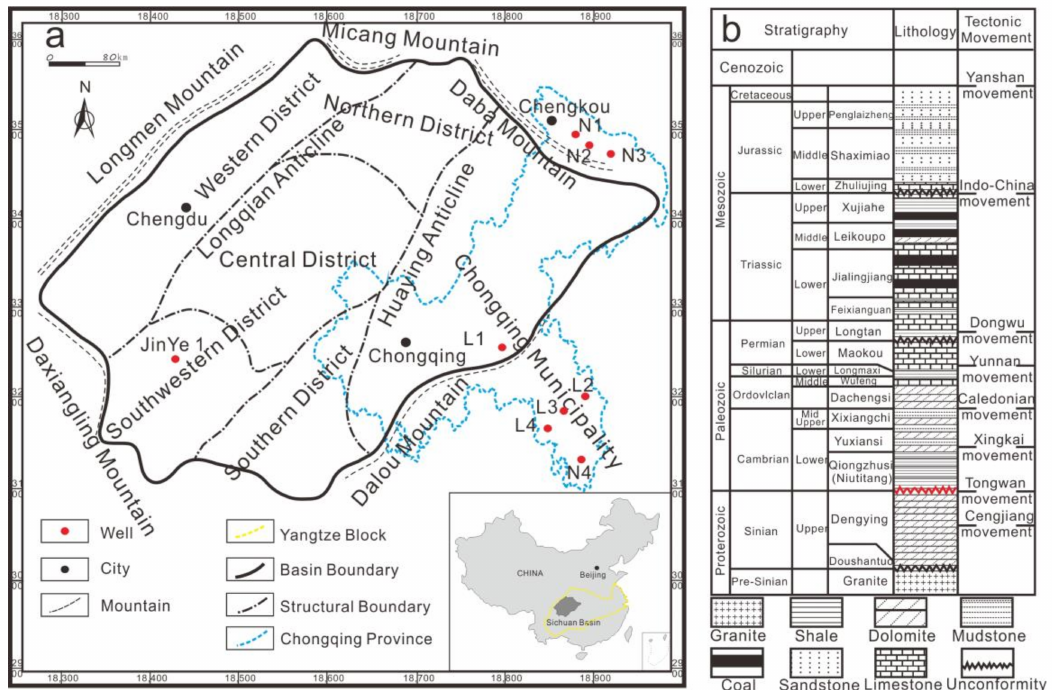
Figure 1. The location and stratigraphic column of the study area. ( a ) Geologic map of the study area in South China; well locations of lower Cambrian shale (N1, N2, N3, N4) and lower Silurian shale (L1, L2, L3, L4) are marked by the red points and ( b ) stratigraphic sequences in the Sichuan